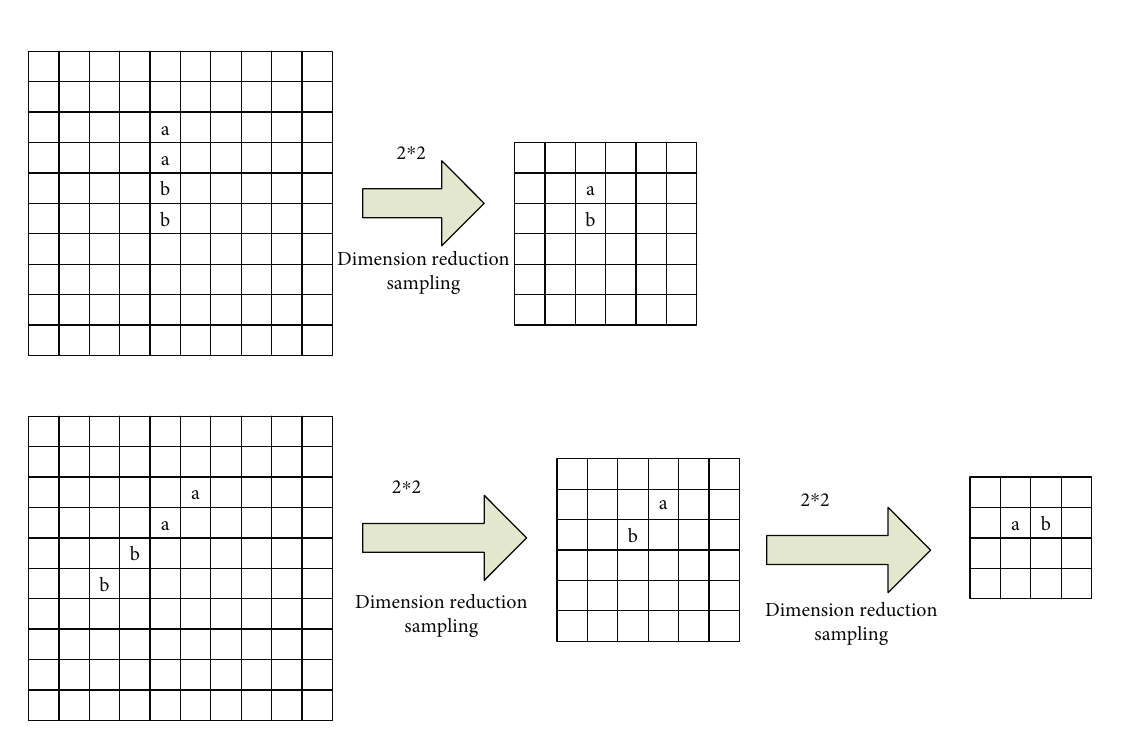
Figure 6: Two types of image pooling. Table 1: Optical spectrum parameters of